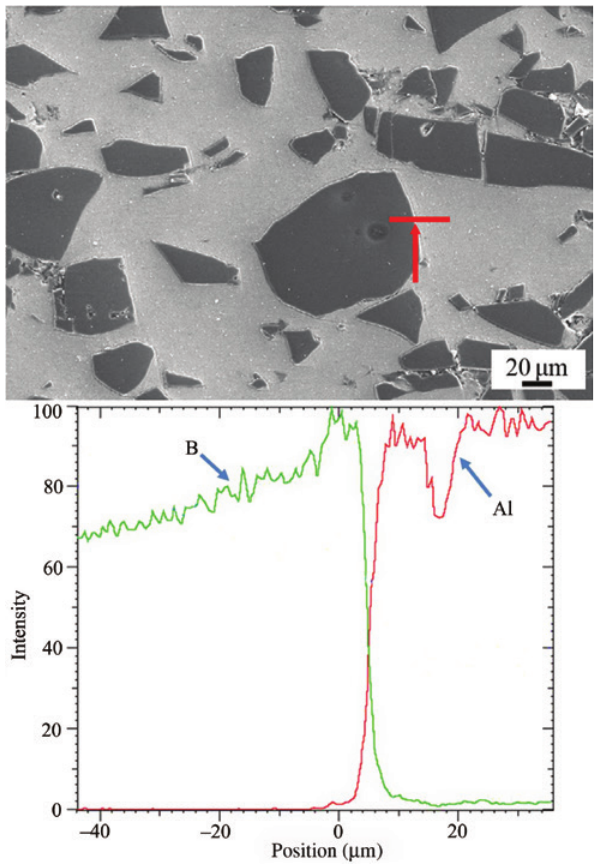
C-Al interface in sample 4